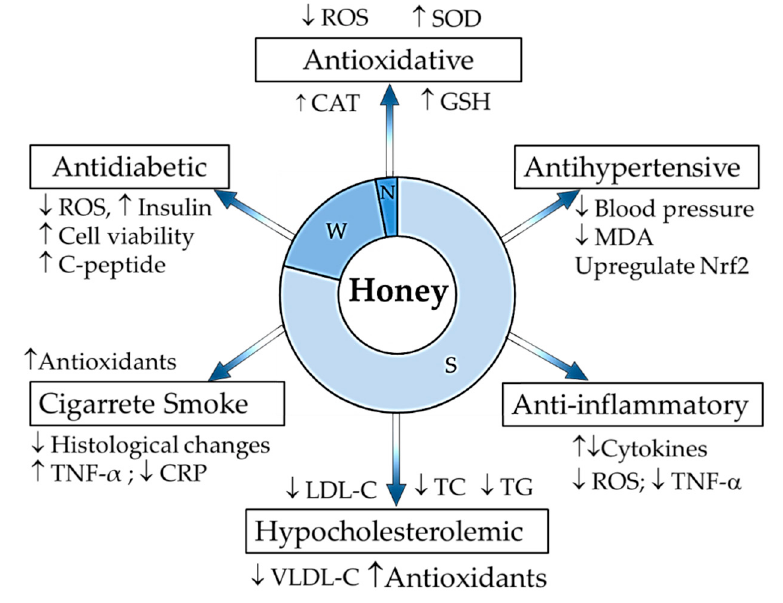
Figure 1. Summary of honey composition and its protective effects against risks in the pathogenesis of atherosclerosis. S: sugar components, W: moisture content, N: non-sugar components, ↓ : decrease; ↑ : increase; ROS: reactive oxygen species; SOD: superoxide dismutase; CAT: catalase; GSH: